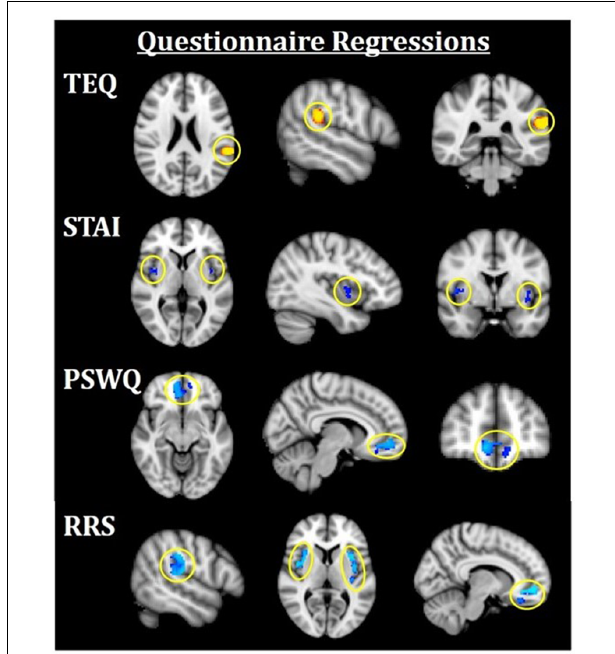
FIGURE 4 | Neuroimaging results for questionnaire score regressions. All results are FWE-corrected, p < 0.05. Red/yellow indicates F > N faces and blue indicates N > F faces. TEQ: higher empathy related to greater activation in the left TPJ (F > N). STAI: increased anxiety related to greater bilateral insula activations (N > F). PSWQ: more worry was related to greater activation in the mPFC (N > F). RRS total: higher total rumination was related to grater activations in bilateral TPJ, bilateral insula, and mPFC (N > F). TEQ, Toronto Empathy Questionnaire; PSWQ, Penn State Worry Questionnaire; STAI, State Trait Anxiety Inventory; RRS, Ruminative Responses Scale; TPJ, temporoparietal junction; mPFC, medial prefrontal